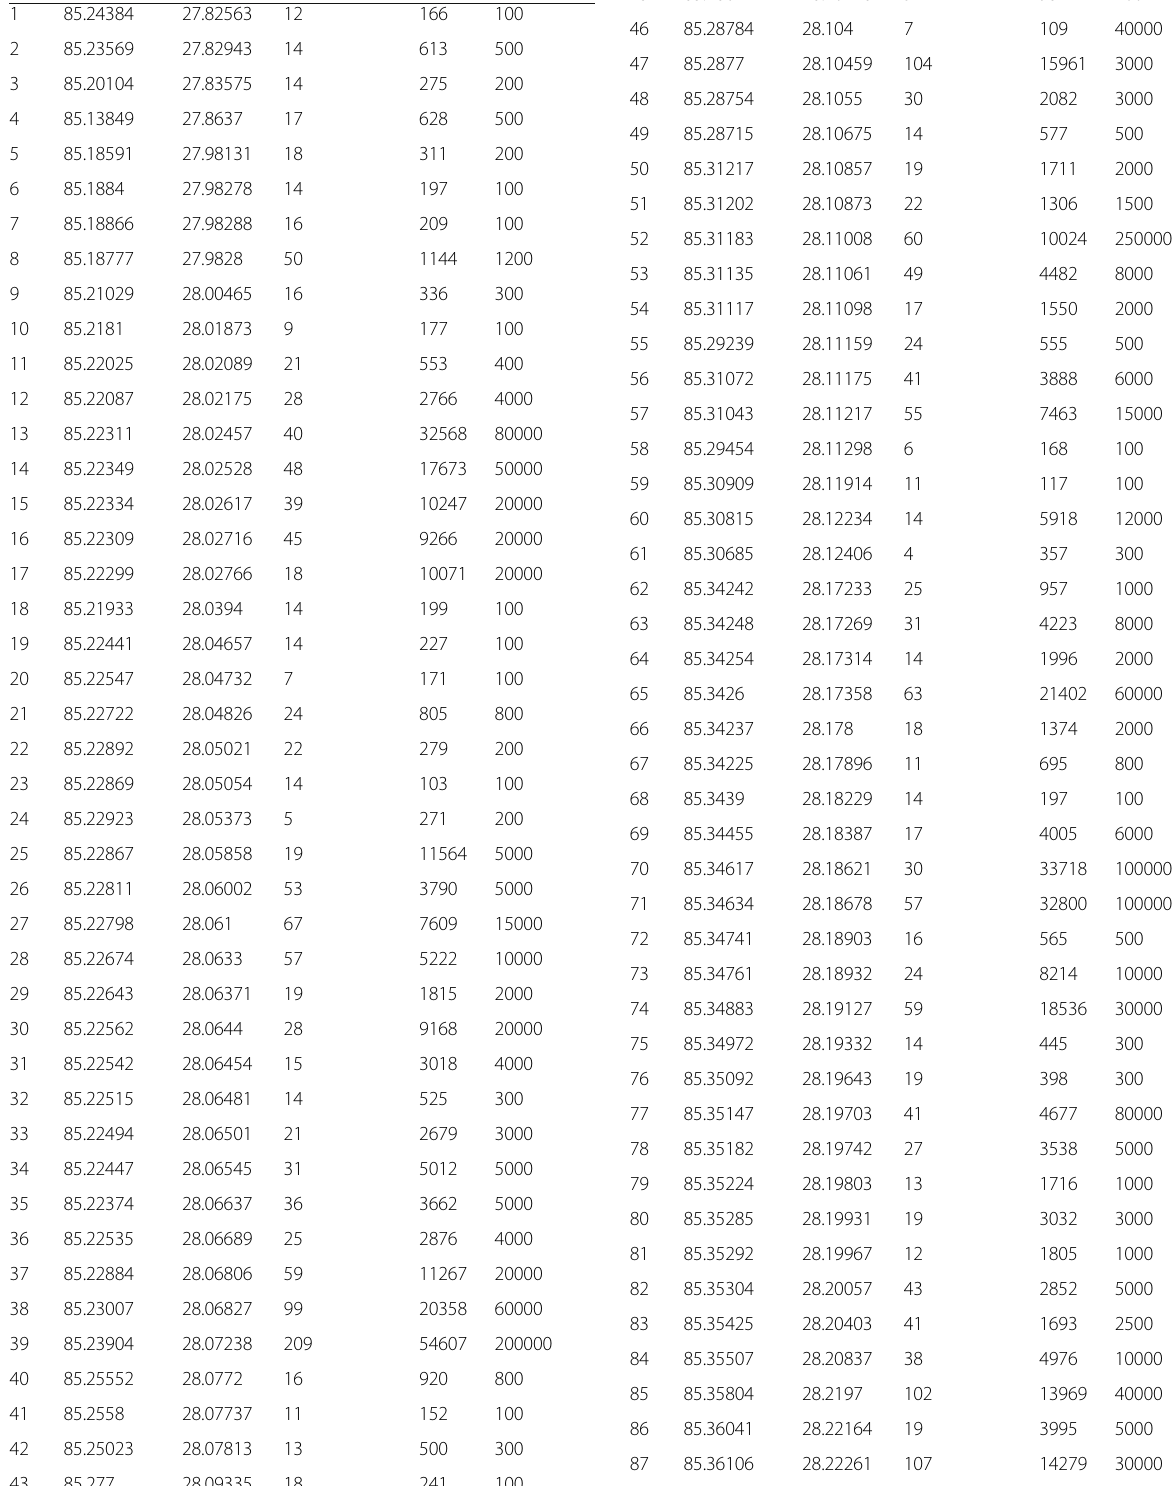
Table 2 Information of damaged along the Pasang Lhamu Highway and associated coseismic landslides